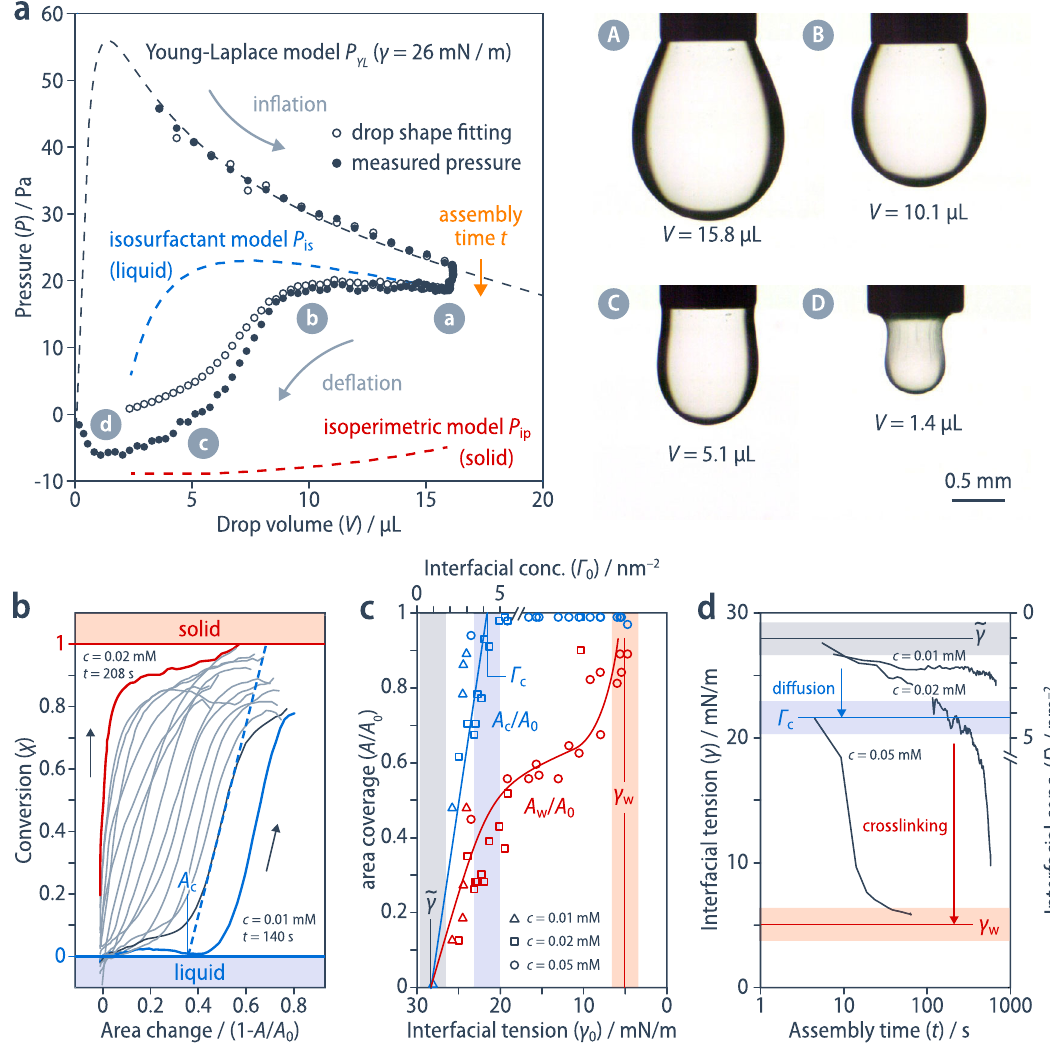
Fig. 2 Pressure-volume curve analysis and kinetics of the fi lm formation. a Example of a pressure – volume curve of a droplet of a solution of 1 ( c = 0.02 mmol/L, t = 23 s) in water. The experimentally measured pressure ( fi lled symbols) is compared to the pressure inferred from the fi tting of the drop shape using the Young – Laplace equation (empty symbols); dashed lines represent the pressure predictions using different models. Images A – D show snapshots of the pendant drop at different stages of de fl ation. b Representative plots of the conversion, χ , of the interface from a liquid to a solid state at various assembly times, t , and concentrations, c , as a function of the relative change in the drop's surface area 1 – A / A 0 ; the critical interfacial area, A c , is de fi ned as the intersection of the tangent at the point of the highest slope with χ = 0, representing the onset at which the interface starts to no longer exhibit a liquid behavior. c Plot of the relative critical interfacial area A c / A 0 (blue) and the relative interfacial area at the onset of wrinkling A w / A 0 (red) versus initial interfacial tension, γ 0 , or the initial interfacial concentration, Γ 0 , observed after the assembly time, t ; e γ is the interfacial tension for the lowest tested concentration of 1 ( c = 0.001 mmol/L) in chloroform/water. d The interfacial tension, γ , of a pendant drop at constant volume is initially rate-limited by the diffusion of the molecular surfactant 1 to the interface; below a critical value corresponding to the critical interfacial concentration, Γ c (blue), its evolution accelerates due to solidi fi cation and fi nally converges to the interfacial tension corresponding to full coverage with a carbon nanoskin